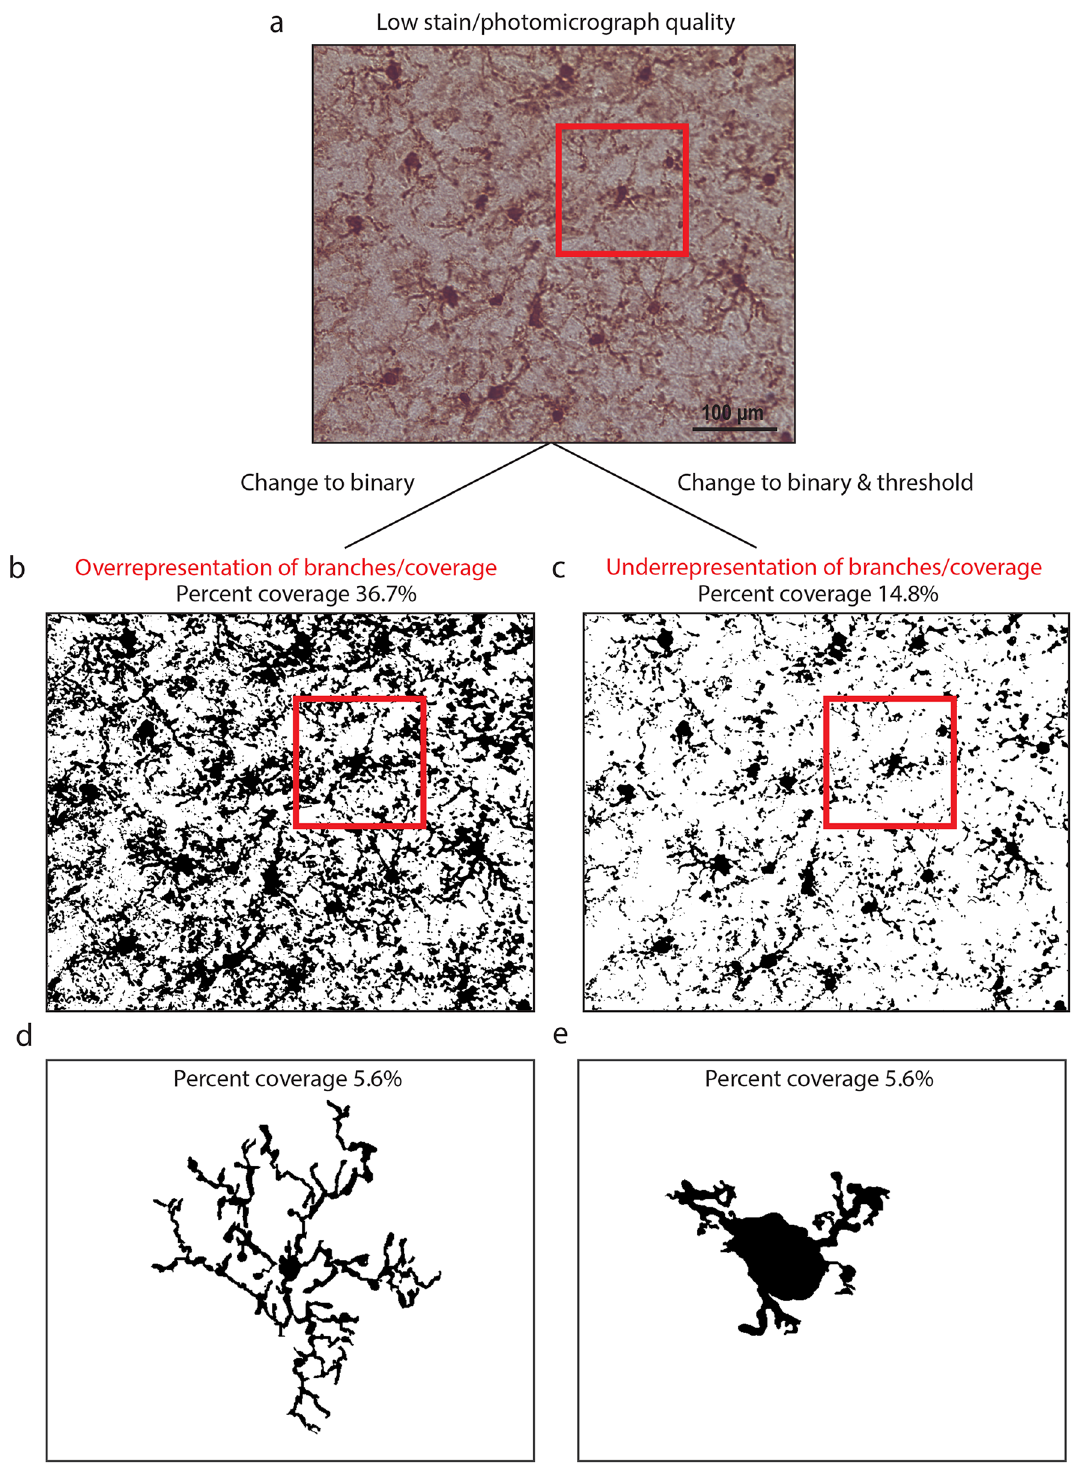
Figure 5. Photomicrograph manipulation can easily change percent coverage and full photomicrograph skeletal analysis results. ( a ) Example of a low-quality image. ( b ) Low-quality photomicrograph displayed in binary with no manipulation. Because of high background staining, microglia are overrepresented as a percent coverage of Iba1 staining. ( c ) When the threshold in B is adjusted to remove some background, some processes on microglial cells are lost and the cells appear less ramified. ( d ) A highly ramified microglial cell with 5.6% percent coverage. ( e ) A sparsely ramified microglial cell with 5.6% percent